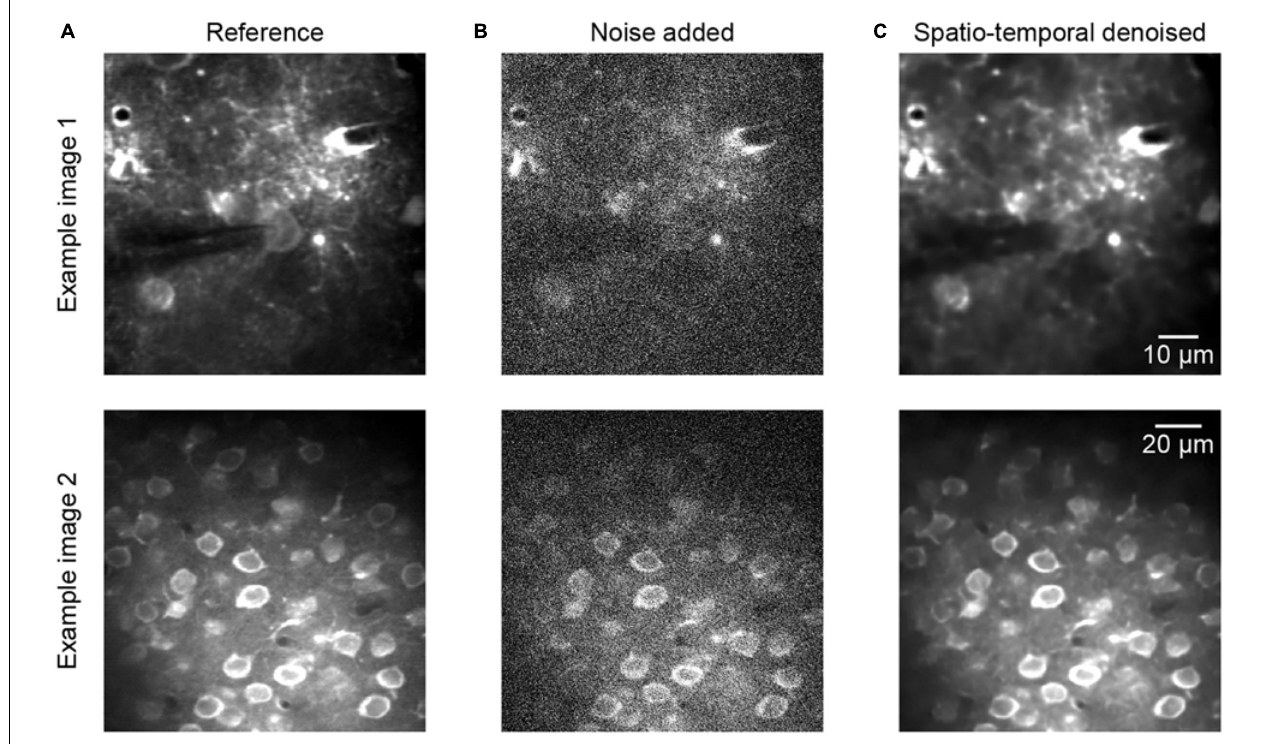
FIGURE 3 | Denoising performance of two representative synthetic two-photon imaging frames. (A) The ground truth references. (B) Poisson and Gaussian noises were added to the two-photon images: example 1 PSNR 18.56/SSIM 0.07 and example 2 PSNR 17.27/SSIM 0.09. (C) Restored images after application of the model blind spatiotemporal filtering method; example 1 PSNR 38.27/SSIM 0.95 and example 2 PSNR 35.94/SSIM 0.90.